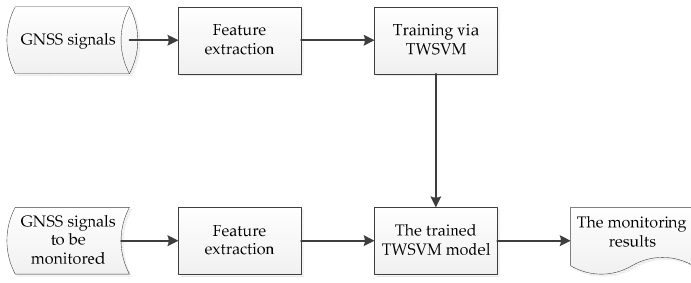
Figure 1. The process chart of the TWSVM-based interference monitoring.